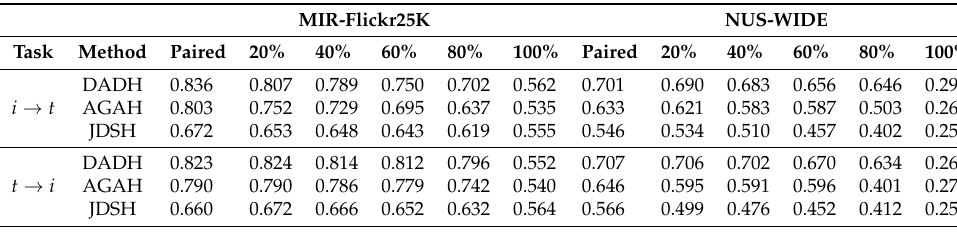
Table 3. Results (mAP) on MIR-Flickr25K and NUS-WIDE with unpaired images, i.e., images with no corresponding text. Column ‘Paired’ shows results when training with a fully paired training set. Subsequent columns show results with increasing amounts of unpaired images in the training set. MIR-Flickr25K